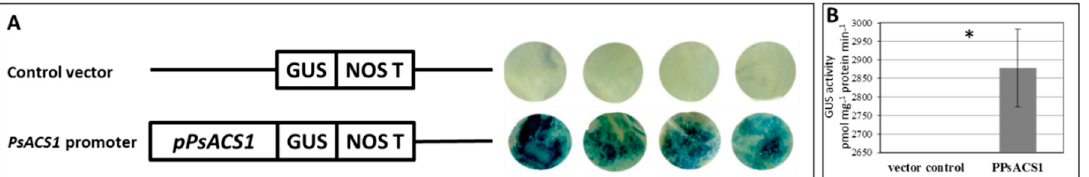
Figure 1. Transient expression of the native 1-amino-cyclopropane-1-carboxylic acid (ACC) synthase 1 ( ASC1) promoter, P PsACS1, in tobacco leaves. The constructs, pPsACS1- β-glucuronidase ( GUS) , and a control vector were Agrobacterium -infiltrated into tobacco leaves (A) and analyzed for GUS activity for 48 h following transformation. Qualitative GUS activities of four replicates from each construct are shown (A). Their average mean values ± SE are shown in (B). (*) indicates significant difference in student t-test ( p ≤ 0.01).